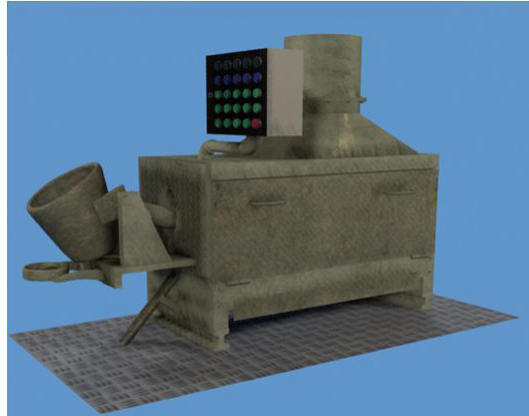
Figure 2. Centrifugal casting machine.